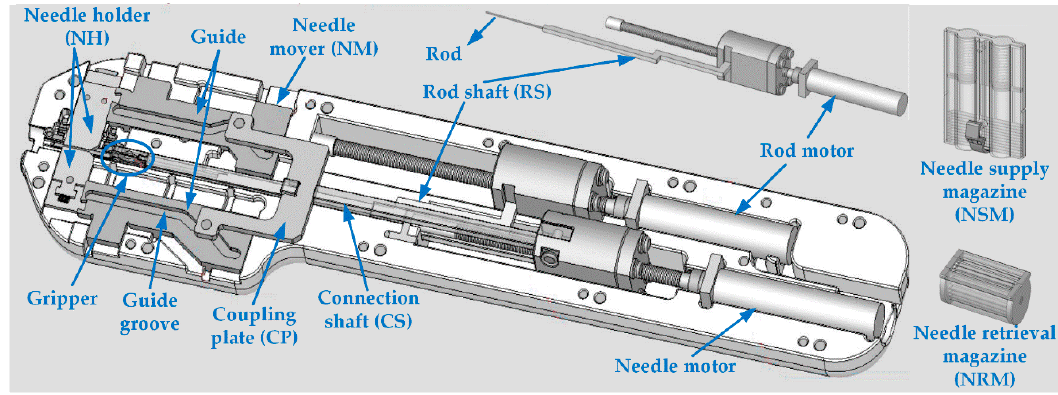
Figure 6. Structure of the proposed semi-automatic implanter.